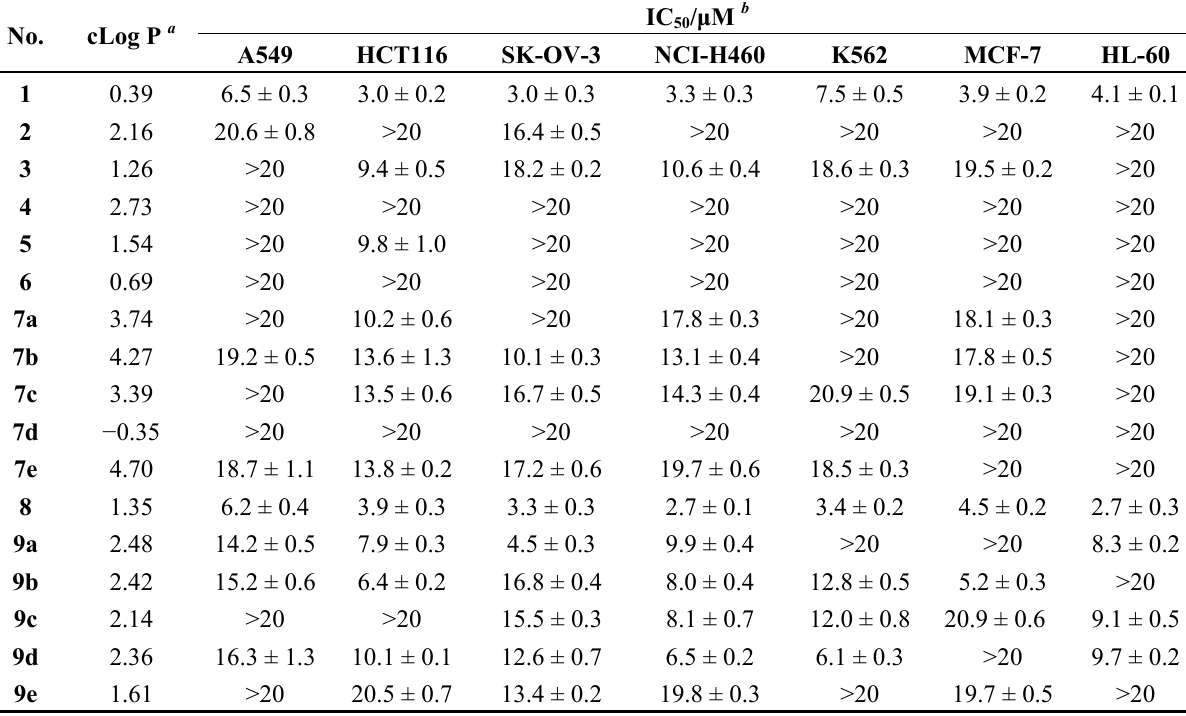
Table 1. In vitro anticancer activities of lycorine